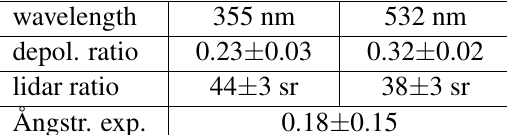
Table 1: Mean and standard deviation of layer-mean intensive parameters (particle linear depolarization ratio, lidar ratio and extinction-related Ångström exponent) of 21 dust events during the CADEX campaign.